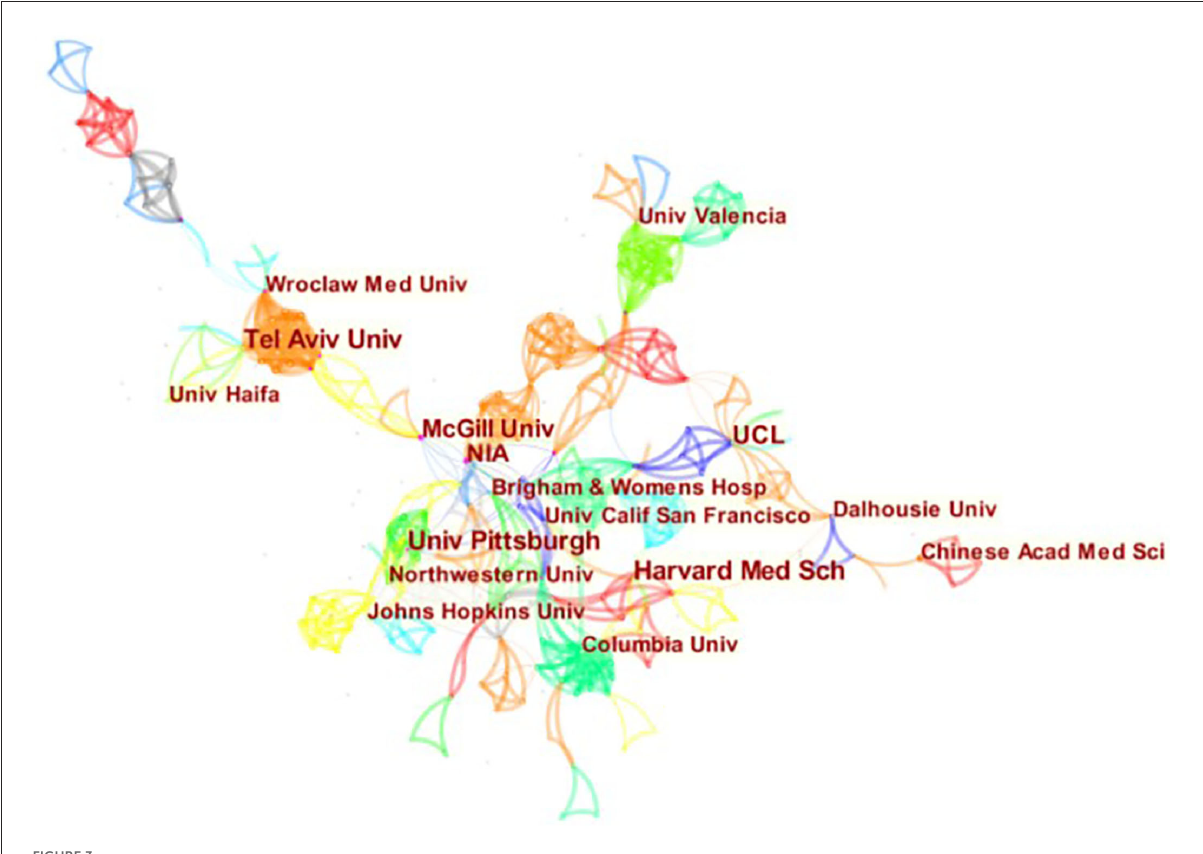
FIGURE3 Map of institutions related to CVD with frailty from 2000 to 2021.